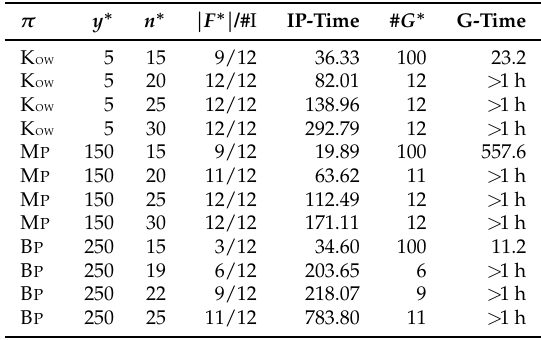
Table 6. Results of Steps 4 and 5 with d max = 4 and θ = 0.